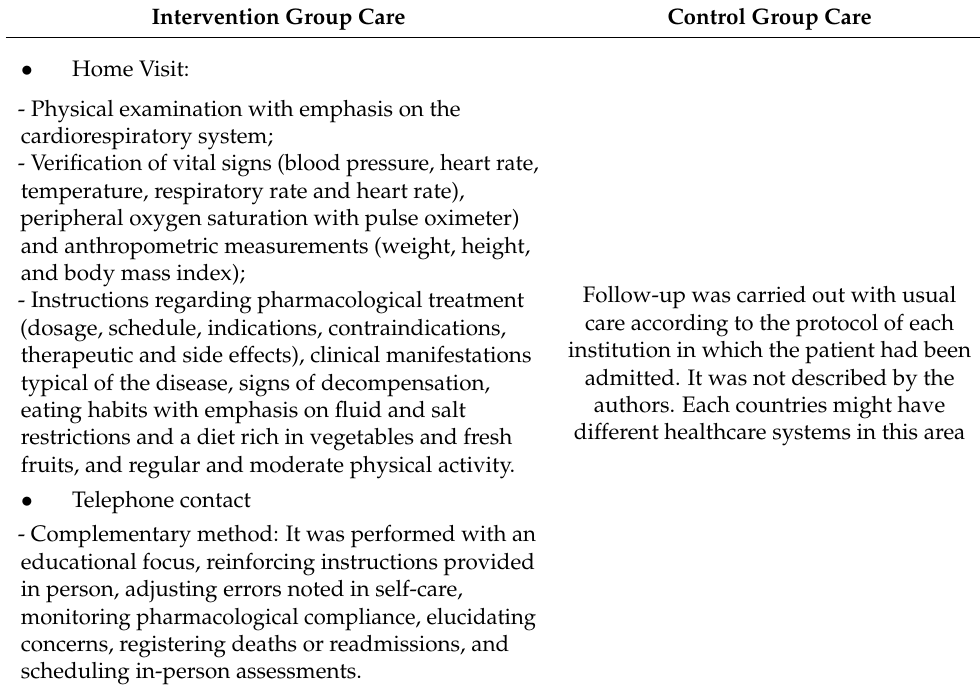
Table 2. Strategies intervention versus